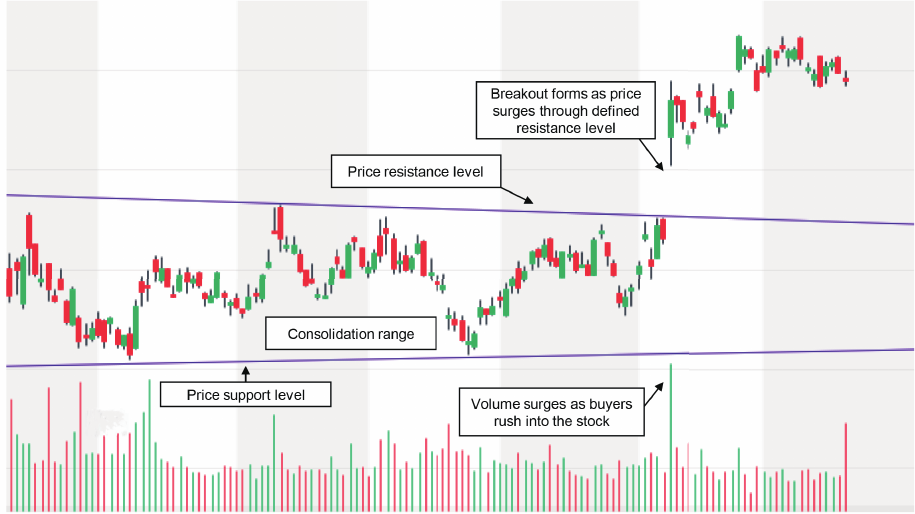
Figure 2. Example of a stock